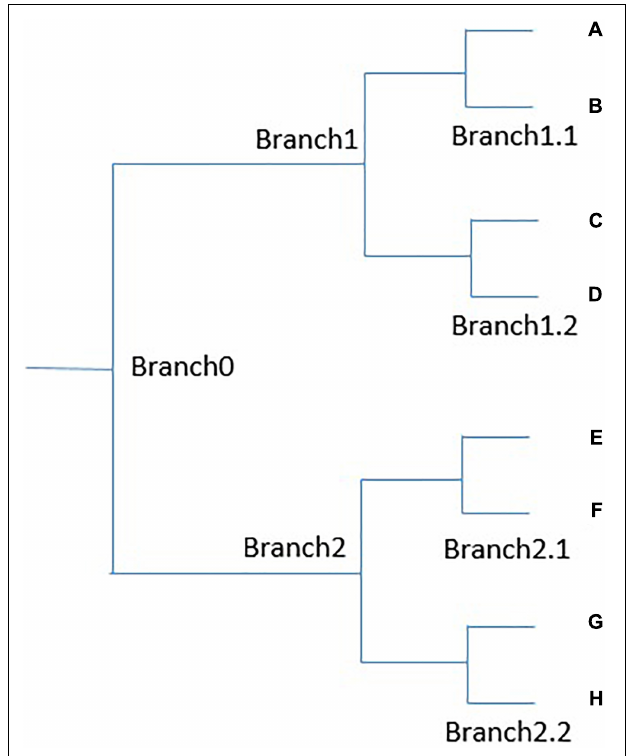
FIGURE 1 | An example binary